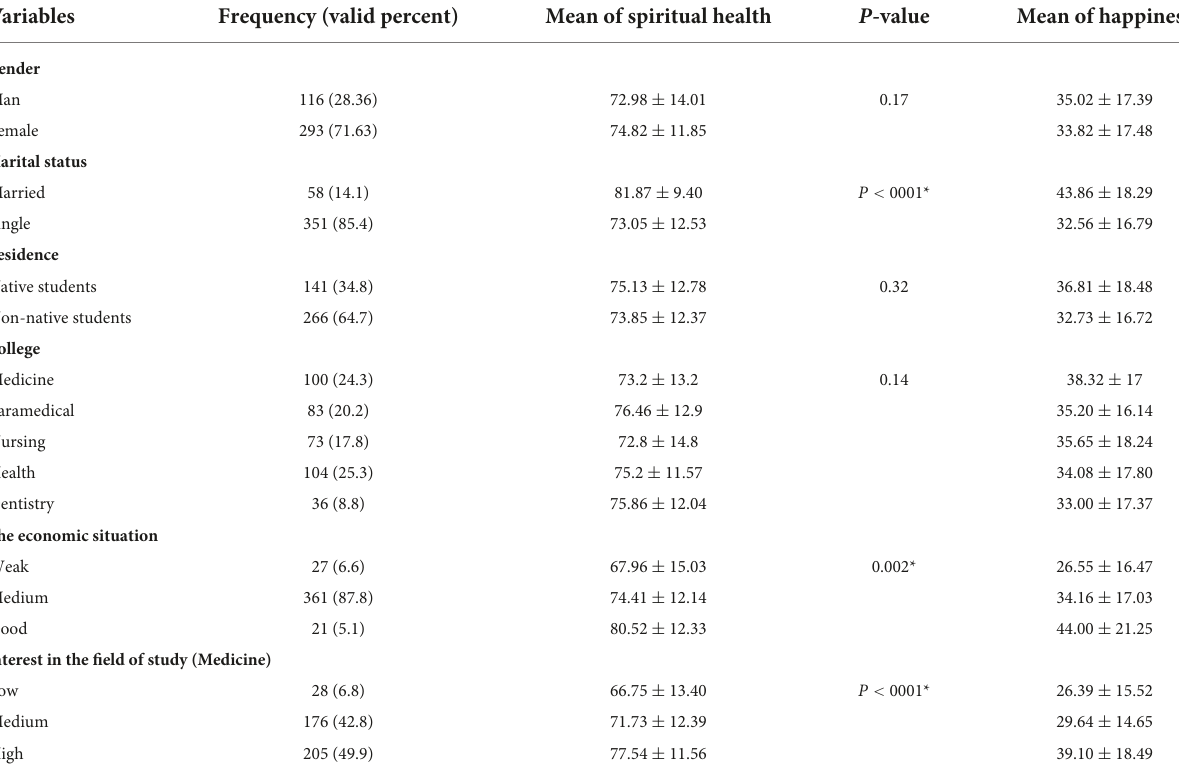
TABLE 1 Demographic variables of students and comparison of mean and standard deviation of happiness score and spiritual health in the study population ( n = 409). Variables Frequency (valid